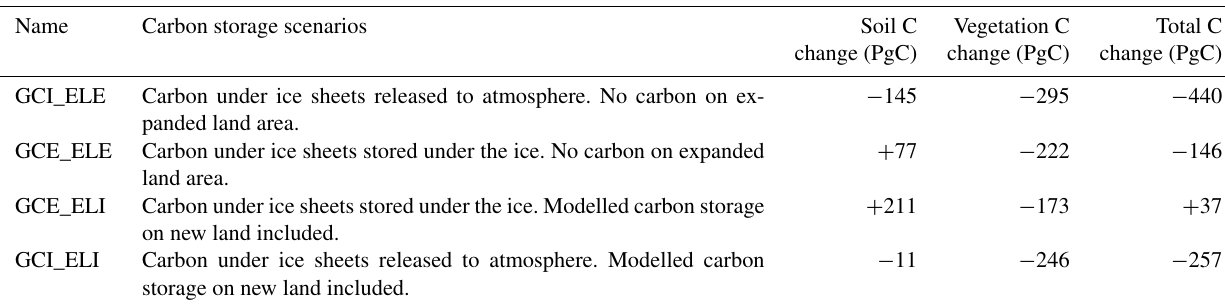
Table 1. Terrestrial carbon changes in the Dynamic simulations from PI to LGM. These numbers are the global totals of the maps in Fig. A4c and e, with the specified parts included/excluded. For the vegetation carbon, these are the values associated with the vegetation changes shown in Fig. A3. For storage values at the LGM, see Table